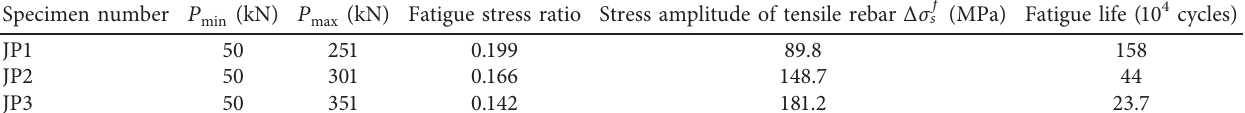
Table 5: Information data sheet of test beams.